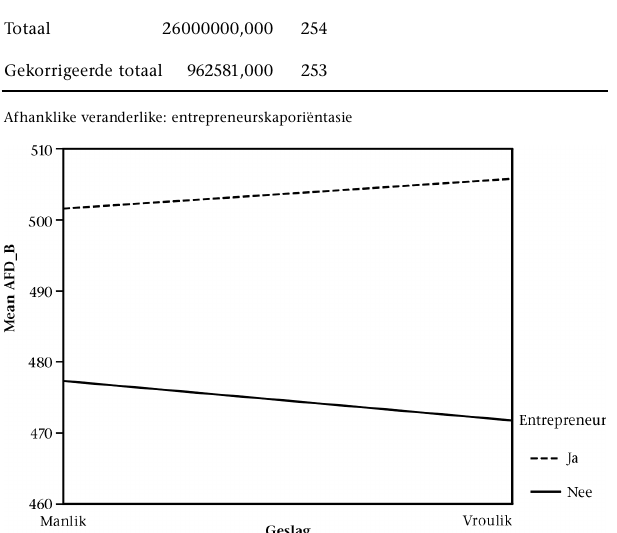
Figuur 2: Entrepreneurskaporiëntasietelling gestip teenoor geslag ten opsigte van entrepreneursstudente en nie- entrepreneursstudente